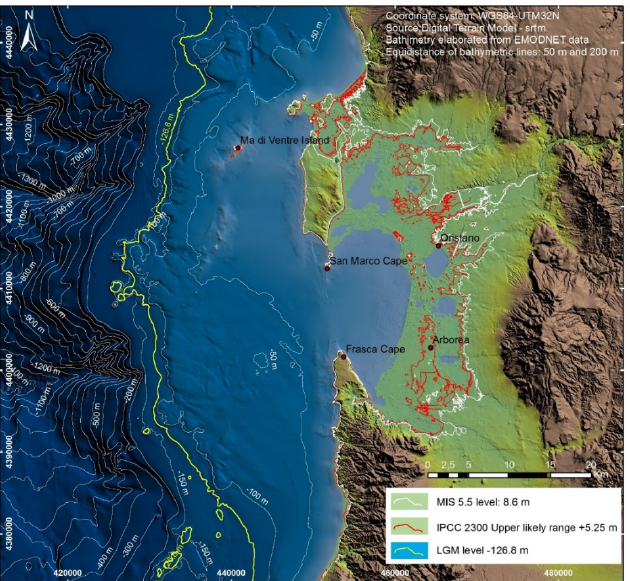
Figure 18. The Oristano plane map showing the potential submersion area using IPCC AR5 RCP 8.5 for 2100 and 2300: the MIS 5.5 extension occurred 119 ka BP.